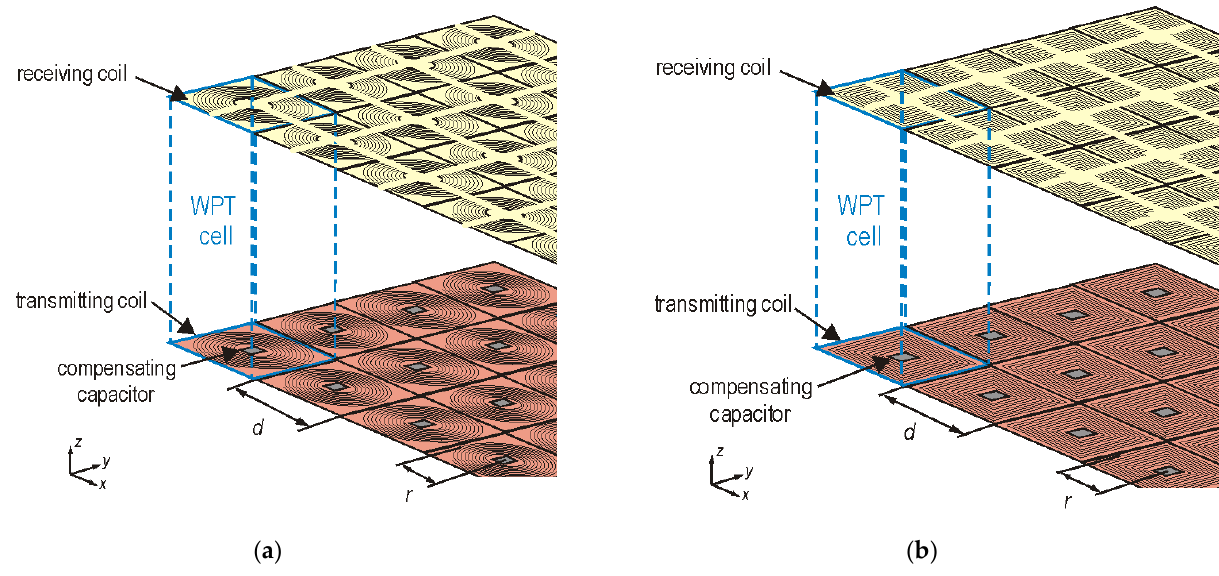
Figure 1. The studied WPT system composed of: ( a ) circular planar coils, ( b ) square planar coils.